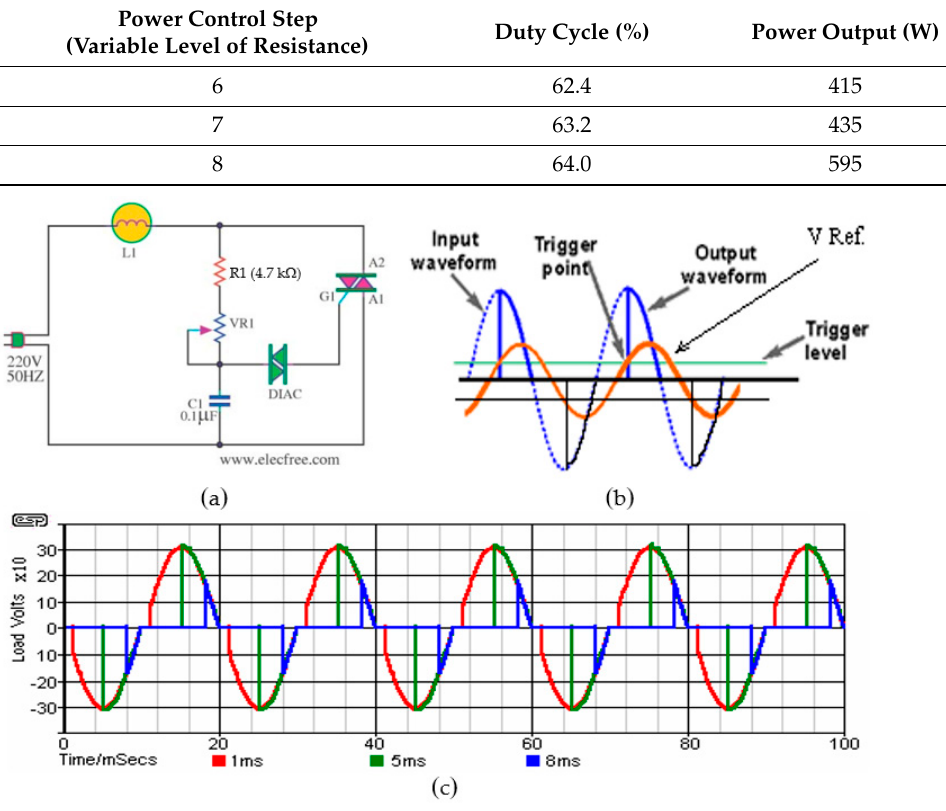
Figure 1. ( a ) The fundamental circuit of the microwave oven’s control unit developed using elecfree.com (accessed on 7 May 2020) [16]; ( b ) The graphical concept of the power control for the microwave oven; ( c ) The voltage output from the control unit with different trigger times (red = 1 ms, green = 5 ms and blue = 8 ms) . Table 3. The relationship between the step of the variable resistor, duty cycle of the transformer input voltage, and the microwave power output.